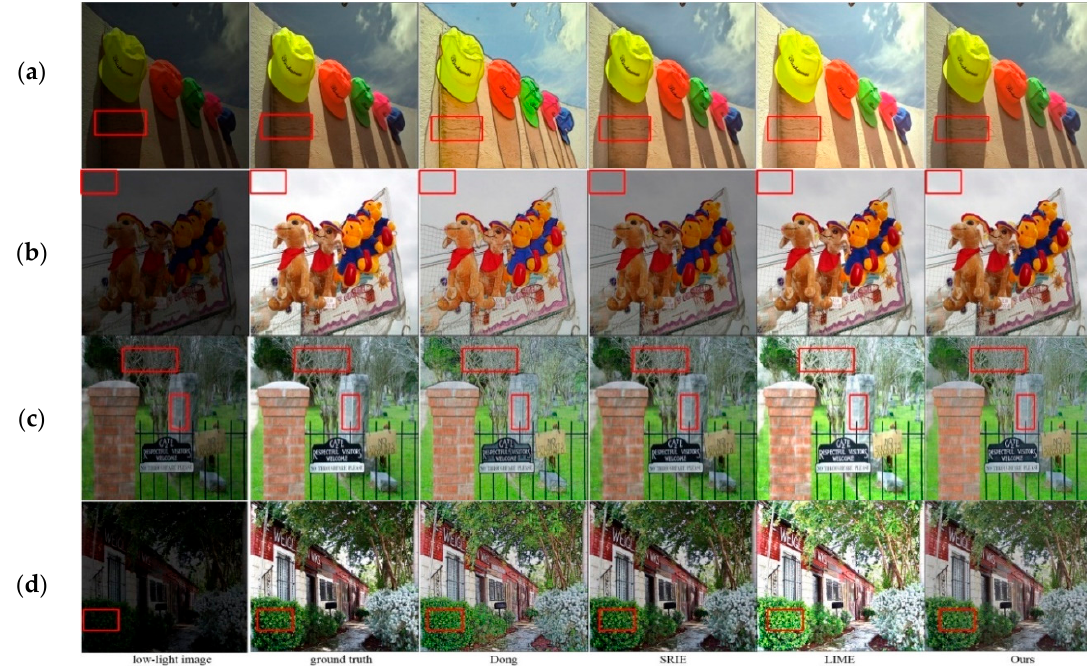
Figure 8. The subjective visual comparison of different algorithms for synthetic low-light images. ( a ) “caps” from LIVE1, ( b ) “carnivaldolls” from LIVE1, ( c ) “cemetry” from LIVE1, ( d ) “building2” from LIVE1. Table 2. Objective evaluation of different algorithms for synthetic low-light images.